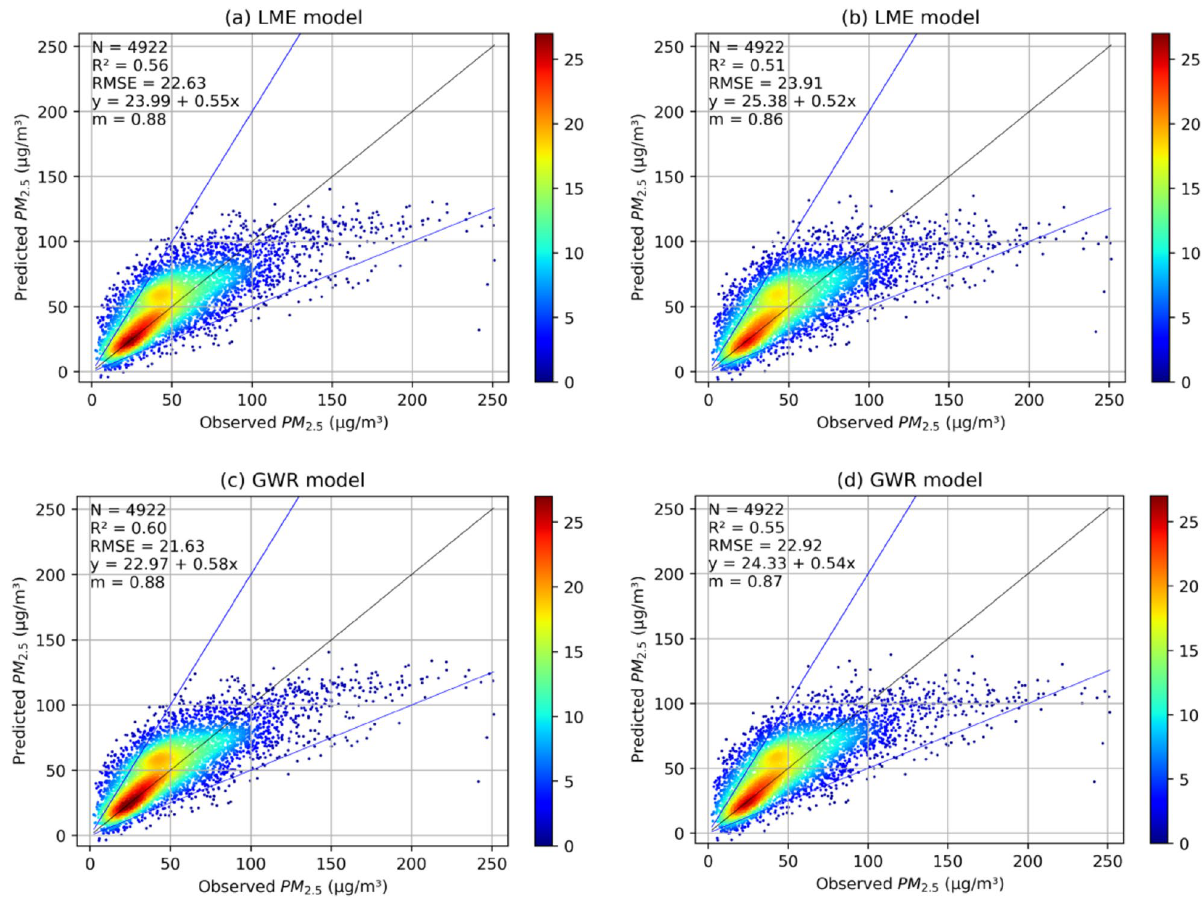
Figure 2. ( a ) LME and ( b ) LME are Model training and tenfold cross-validation of LME model, respectively over Madhya Pradesh during 2018–2019 and ( c ) GWR is GWR model training and ( d ) GWR is after tenfold CV (caxis is the point count). The blue lines are the y = 2 × and y = x/2 while black is x = y line. “m” is the slope if the regression is forced through